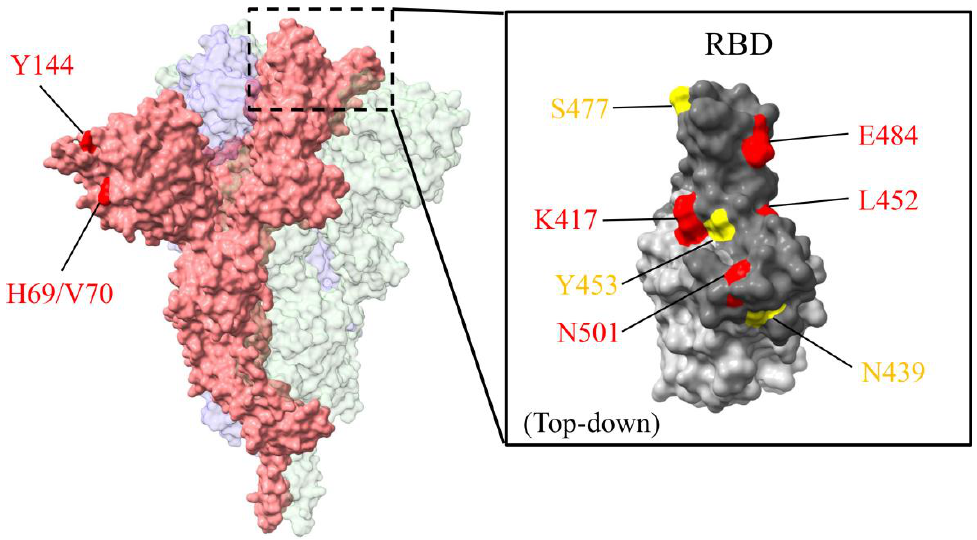
Figure 2. Structure of severe acute respiratory syndrome coronavirus 2 (SARS-CoV-2) S glycoprotein with current emerged mutations. Mutations existing in more than 1% of total sequences are shown. One monomer of S glycoprotein is shown in pink. The structure of the receptor binding domain (RBD) is enlarged in right panel and receptor binding motif (RBM) is shown in dark gray. Mutations in currently emerged SARS-CoV-2 variants are labeled in red, whereas others are in yellow. Structure depicting S glycoprotein using PDB: 6XR8. Structure depicting RBD using PDB: 7BWJ. Figures are generated by UCSF ChimeraX software.